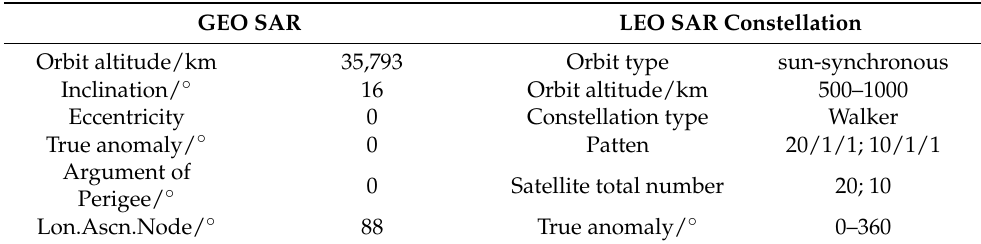
Figure 10. The sketch of simultaneous observation of China by a GEO SAR and a LEO SAR constellation (Walker Patten 20/1/1); ( b ) is the zoom of the green box in ( a ). Table 8. Orbital elements of the GEO SAR and LEO SAR constellation.